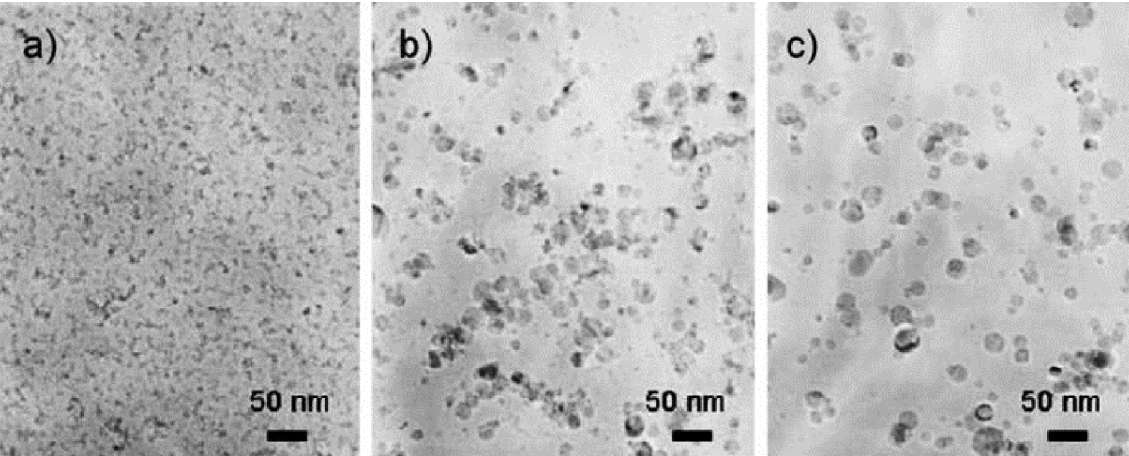
Fig. 5. Micrographs of NTPs deposited on steel substrate with titanium precursor mass flows in flame: (a) 11 mg/min, (b) 240 mg/min and (c) 690 mg/min, reprinted with permission from J.M. Mäkelä, S. Hellstén, J. Silvonen, M. Vippola, E. Levänen and T. Mäntylä // Mater. Lett. 60 (2006) 530, (c) 2005 Elsevier.